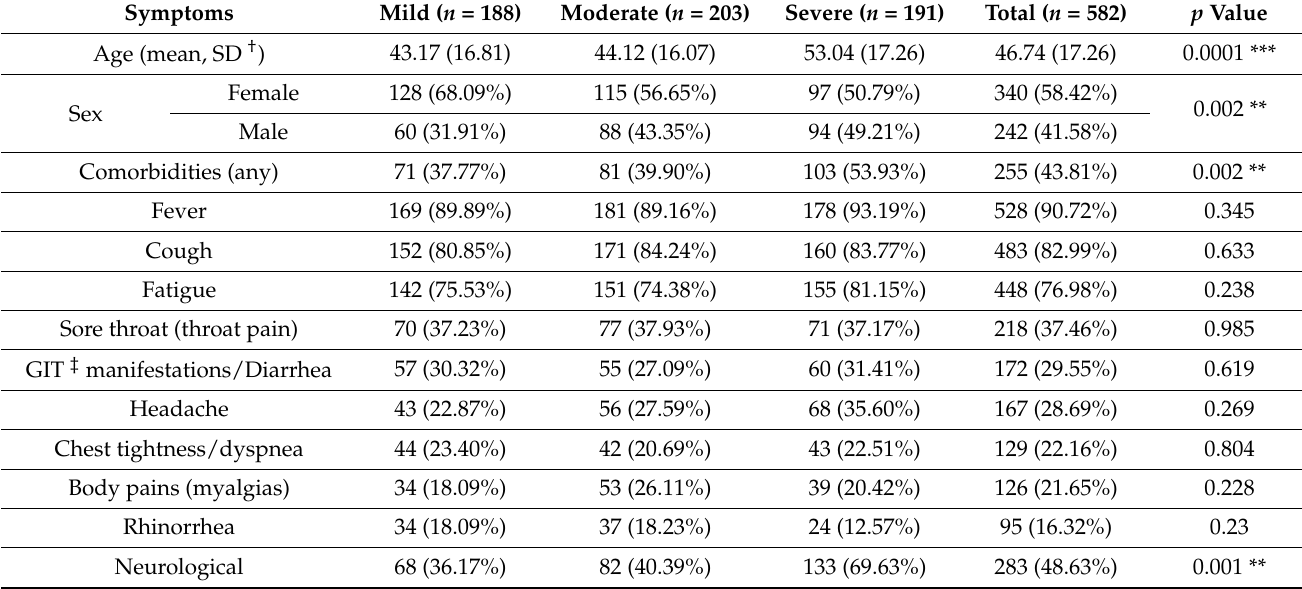
Table 2. Clinical manifestations of different degrees of COVID-19